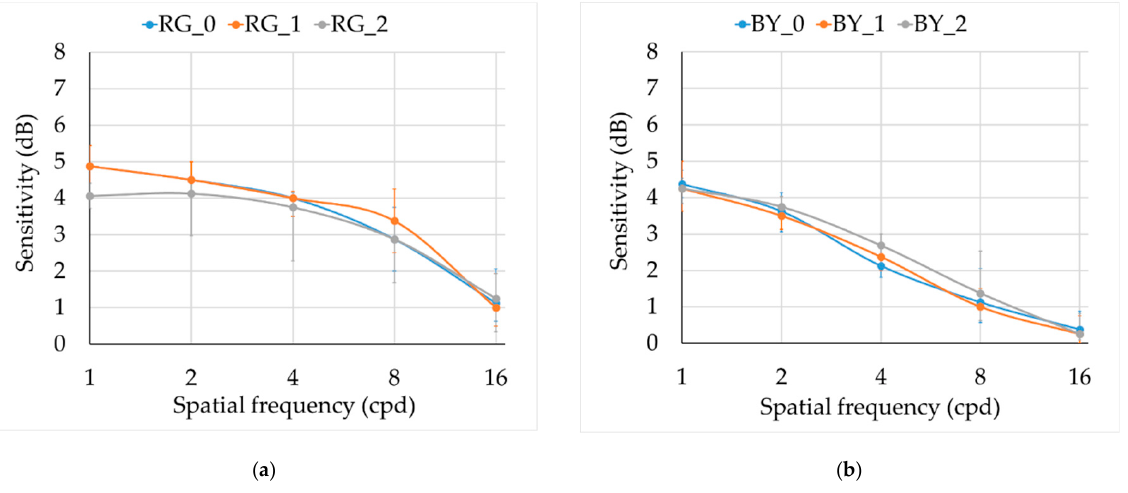
Figure 4. Chromatic monocular CSFs. Median and interquartile range for three groups: 0 = control (blue), 1 = moderated smokers (orange), and 2 = severe smokers (grey): ( a ) RG mechanism, ( b ) BY mechanism. Table 2. Statistic results for the achromatic (A) and chromatic (RG and BY) contrast sensitivity comparison among groups at each